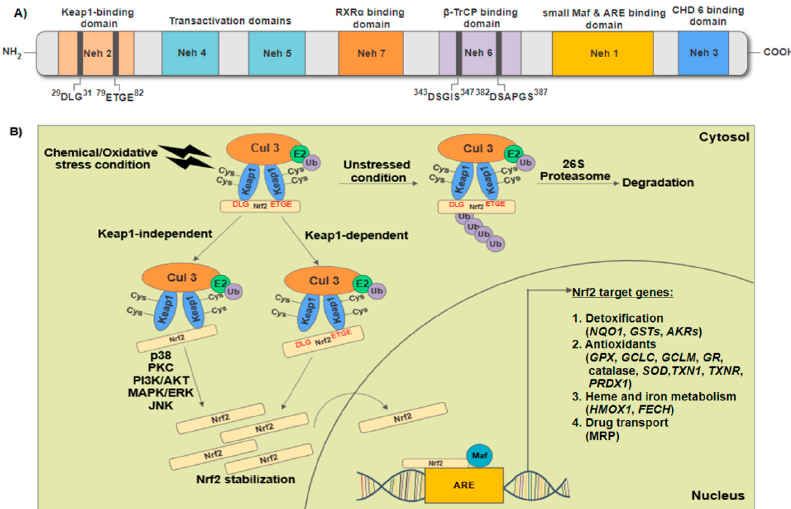
Figure 2. Nuclear factor erythroid 2-related factor 2 (Nrf2) regulatory pathway. ( A ) Structural Nrf2-ECH homology (Neh) 1–7 domains of human Nrf2 protein; ( B ) Keap1-dependent and